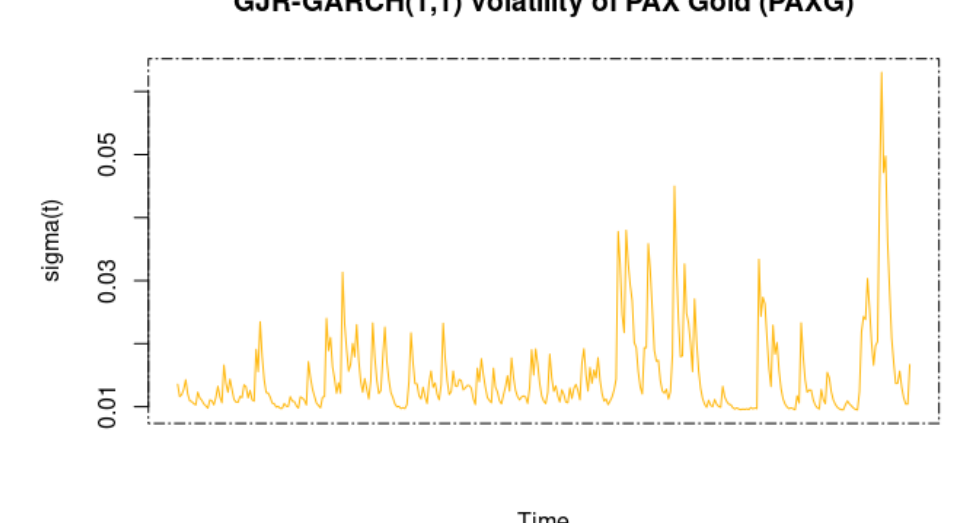
Figure 16. Volatility extracted from AR(1)-GJR-GARCH(1,1) model for PAX Gold (PAXG)— CoinMarketCap.